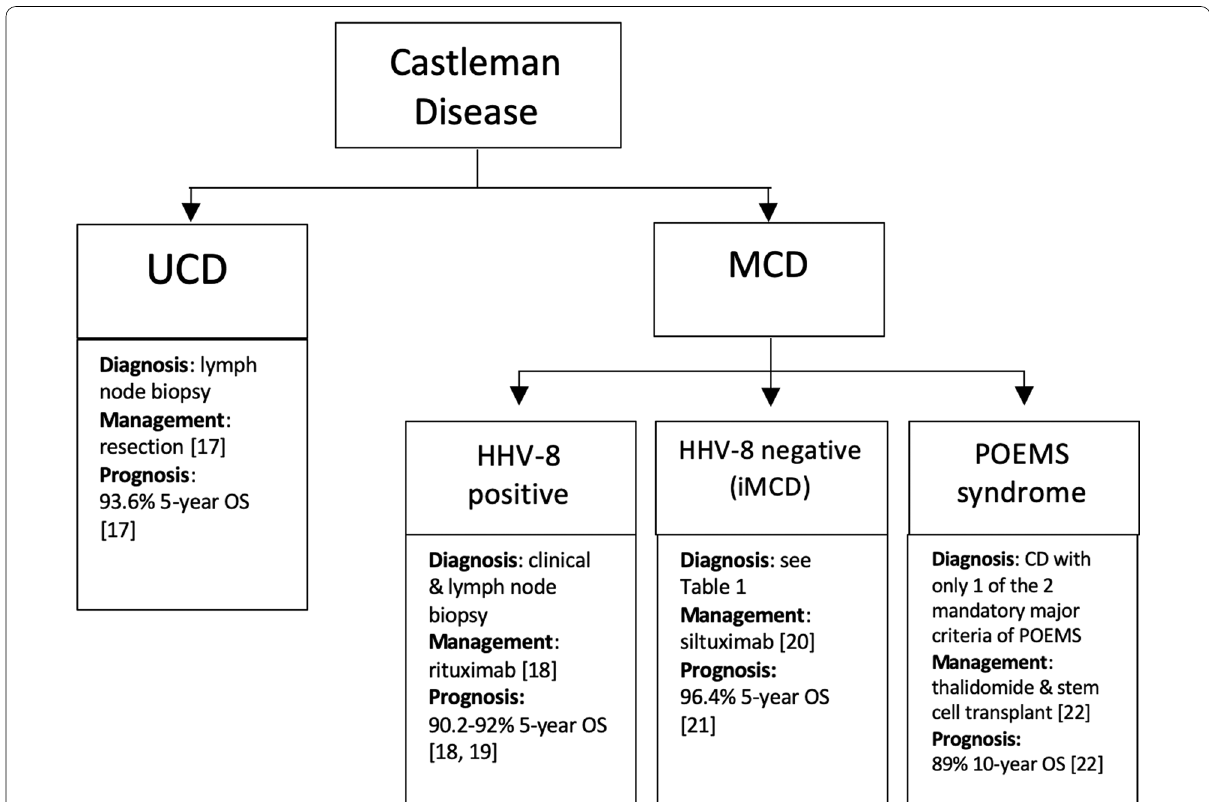
Fig. 1 Summary of the main types of Castleman disease [17–22]. UCD, unicentric Castleman disease; MCD, multicentric Castleman disease; HHV‑8, human herpesvirus‑8; iMCD, idiopathic multicentric Castleman disease; POEMS, polyneuropathy, organomegaly, endocrinopathy, monoclonal protein, skin